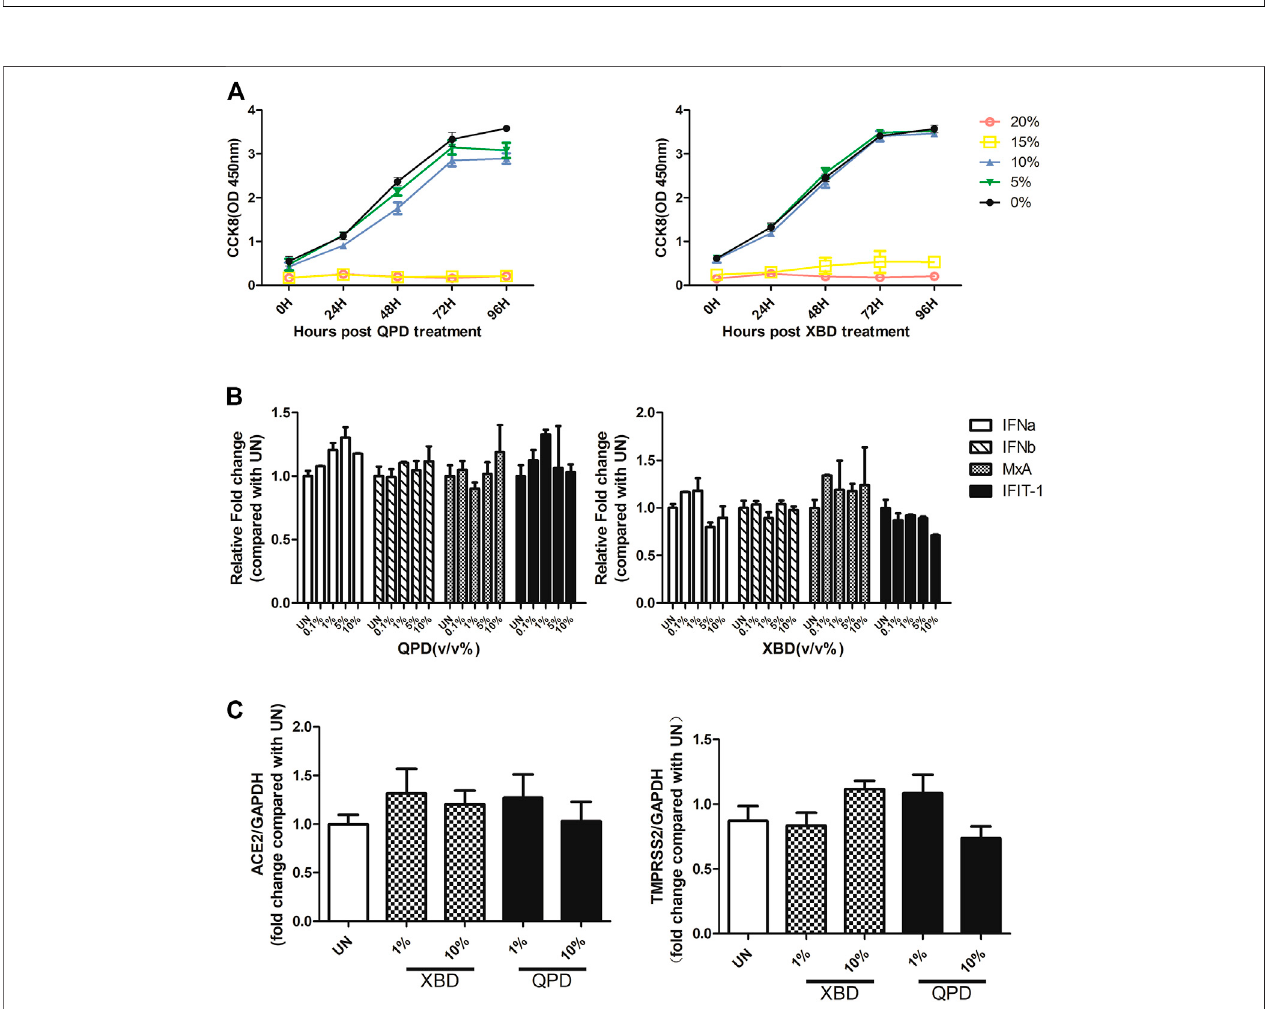
FIGURE2| EffectofQPDandXBDonIFNsignalingpathway,ACE2, andTMPRSS-2 inA549cells. (A): CytotoxiceffectofQPD(left)andXBD(right)onA549cells. A549cellswereseededat 6 × 10 5 /ml,2 mlperwell in6-wellplates for24 h beforeQPDor XBDwasadded intoeach wellat indicatedconcentrations(%, v/v).48 h post QPDorXBDtreatment,totalRNAwasextractedtodetectIFN α ,IFN β ,MxA,IFIT-1mRNAs (B) orACE2andTMPRSS-2mRNAs (C) byRT-qPCR.UN,untreatedcontrol. Data are presented as mean ± SD ( n ≥ 3).